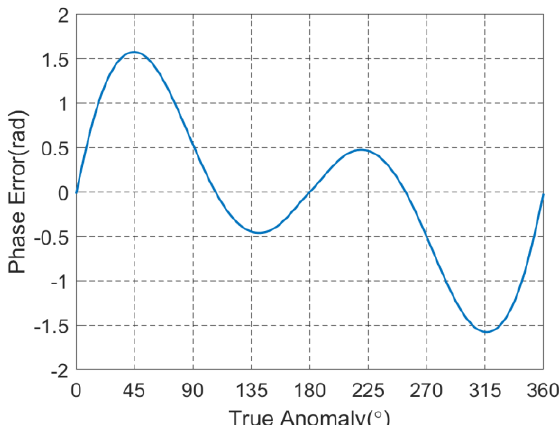
Figure 14. The fitting errors of the fourth-order Taylor expansion with 1000 s observation time at